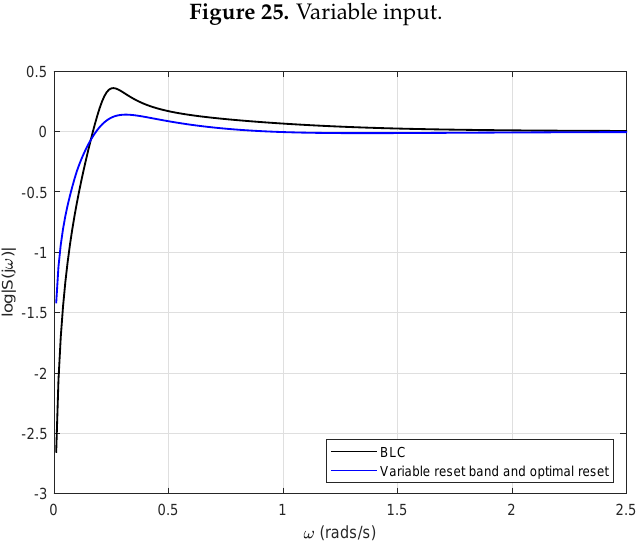
Figure 25. Variable input.